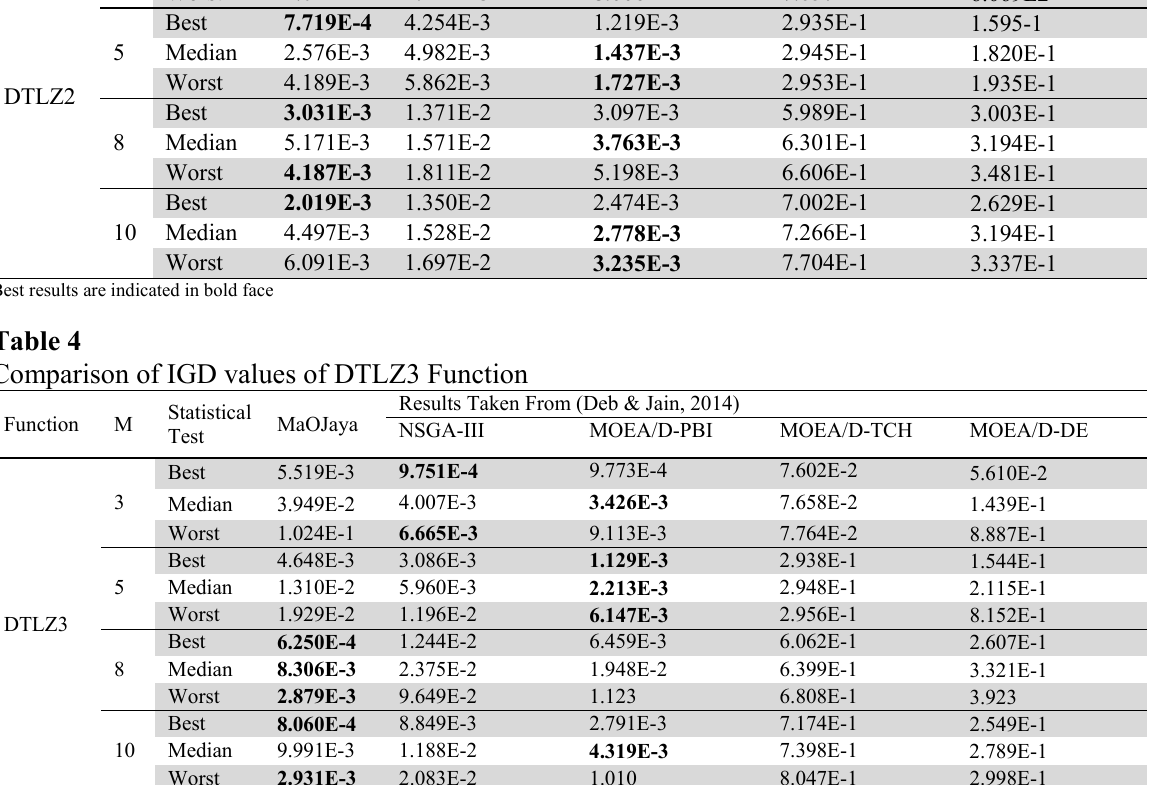
Comparison of IGD values of DTLZ2 Function Statistical Function M MaOJaya Test